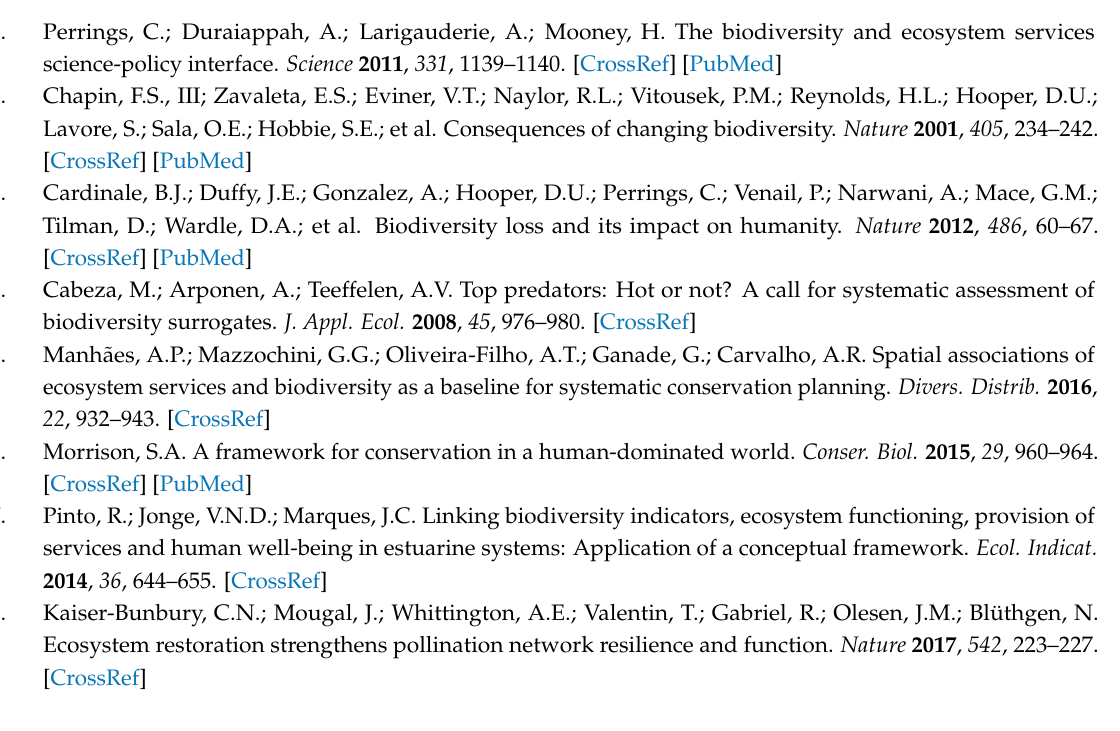
Supplementary Material S1: Selection of indicator species in Qingling mountain study, Supplementary Material S2: Biodiversity mapping in mainland China study, Supplementary Material S3: Examples of ROC curve verification of mammal indicator species in Qinling Mountain, Supplementary Material S4: Modeling of soil retention, Supplementary Material S5: Mapping of ecological